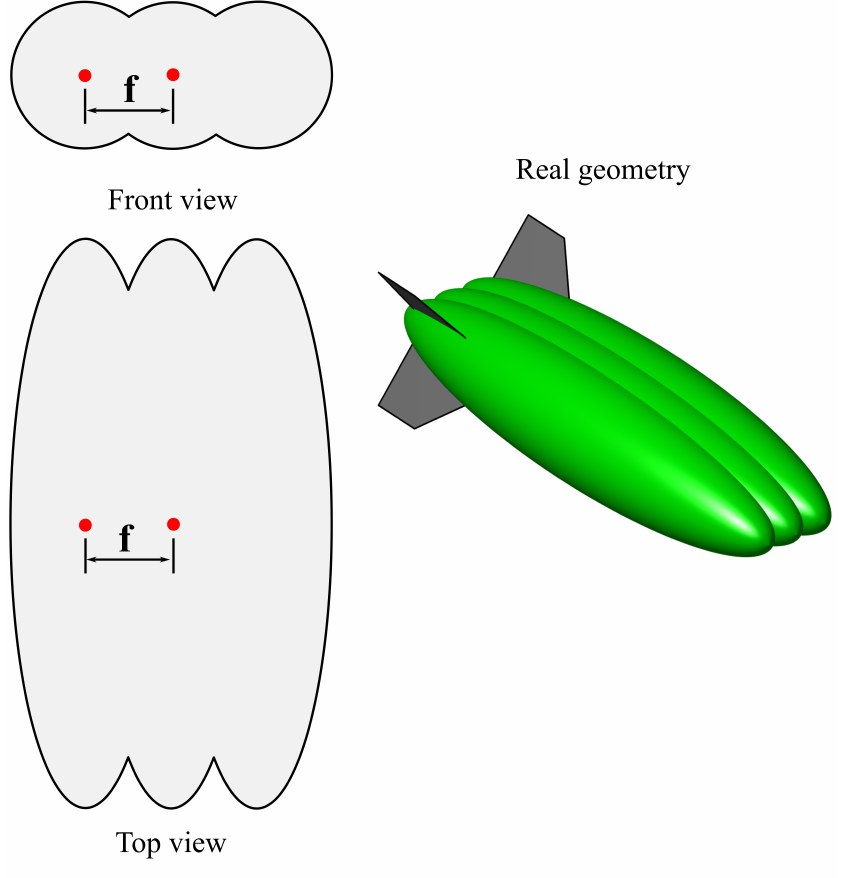
Figure 5. Tri-lobed dynastat